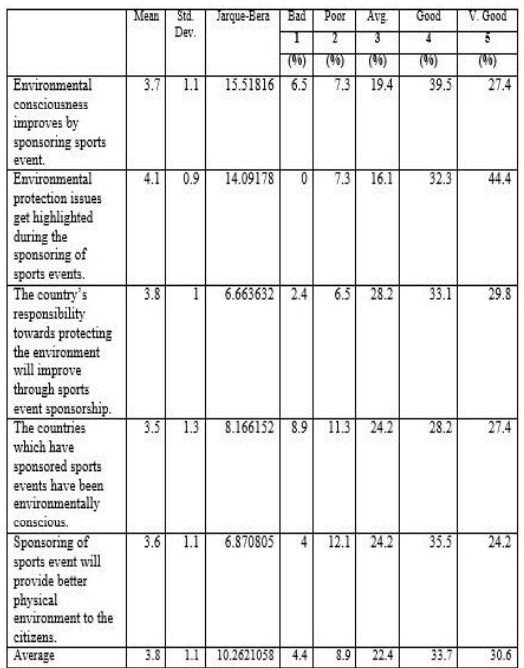
Table 7: Environmental